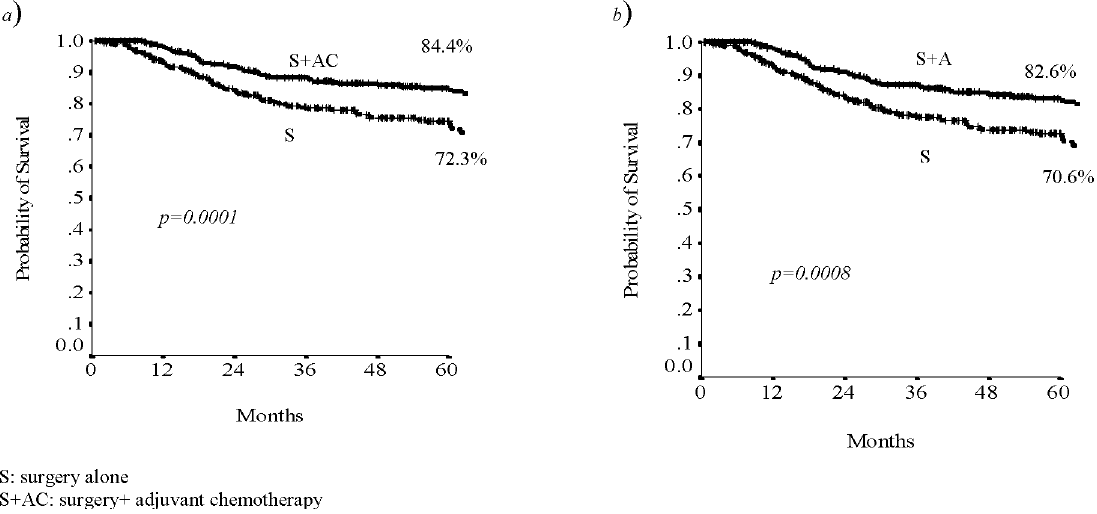
Figure 1. The 5-years RFS (a) and DFS (b) related to treatment. doi:10.1371/journal.pone.0080188.g001 PLOS ONE |